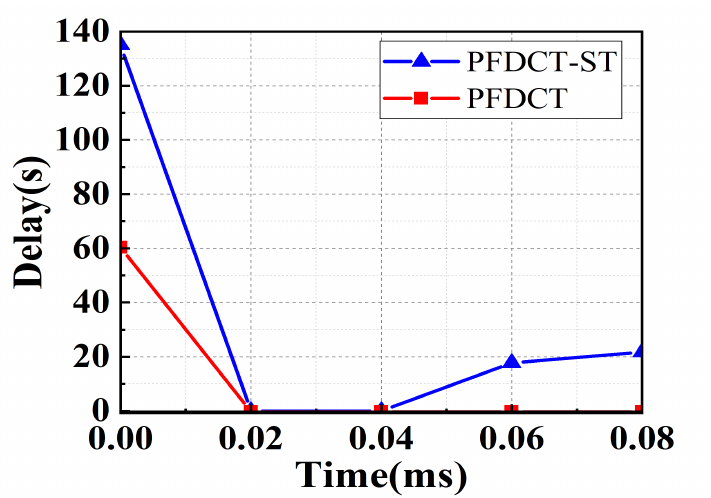
Figure 5. End-to-end delay comparison between PFDCT and